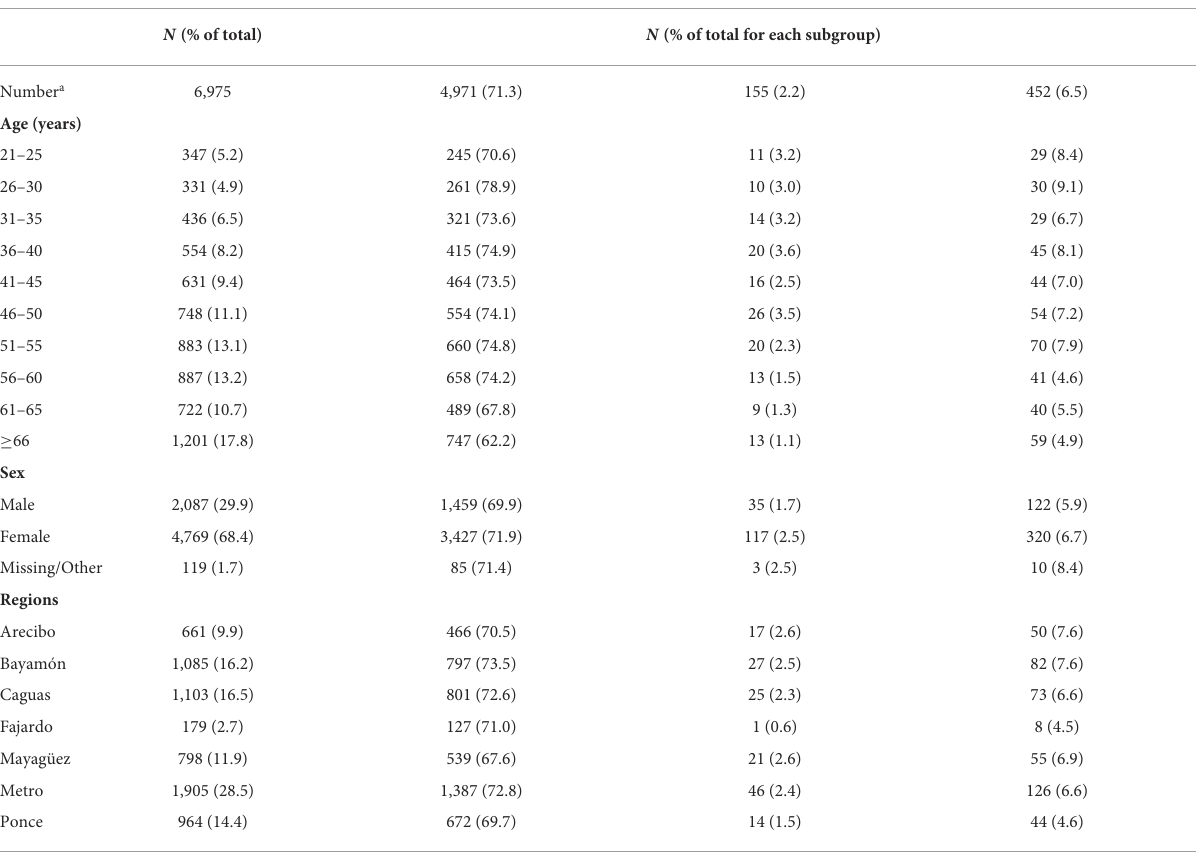
TABLE 1 Distribution of participants and COVID-19 cases since the lockdown by age, sex, and regions.